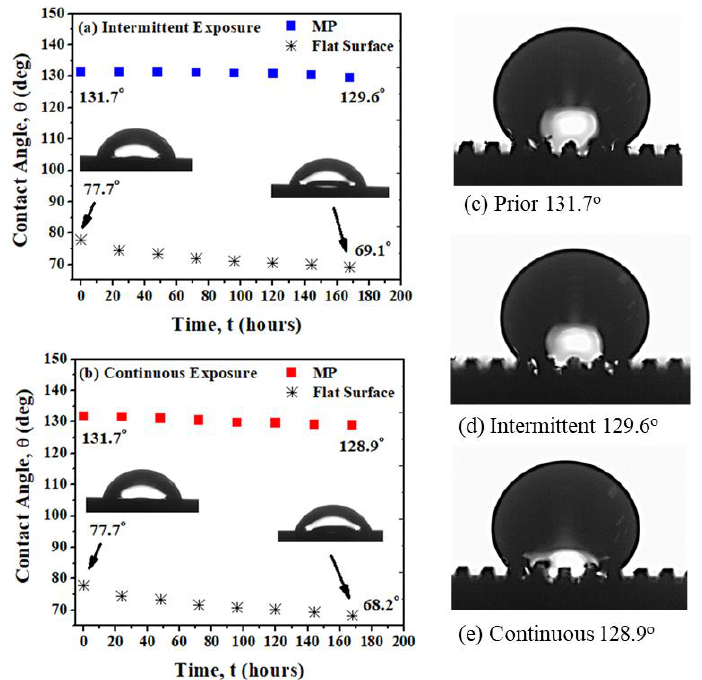
Figure 4. Measured contact angle value (CA) of the flat surface and MP as a function of exposure time to the NaCl solution (t ≈ 168 h): ( a ) intermittent exposure and ( b ) continuous exposure. Insets in ( a , b ) show images of water droplets on the flat surface, taken before and after long-time contacts with NaCl solution, in the corresponding conditions of exposure. Images of water droplets on micropillar surface (MP): ( c ) before long-time exposure, ( d ) after intermittent exposure and ( e ) after continuous exposure to NaCl solution.